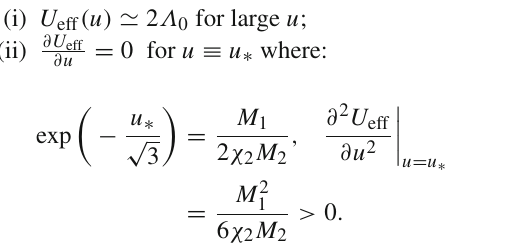
Fig. 2 Phase space portrait of the autonomous system (30). The x axis denotes the relative kinetic part of the scalar inflaton, and the z axis denotes the relative part of the dark energy density Λ